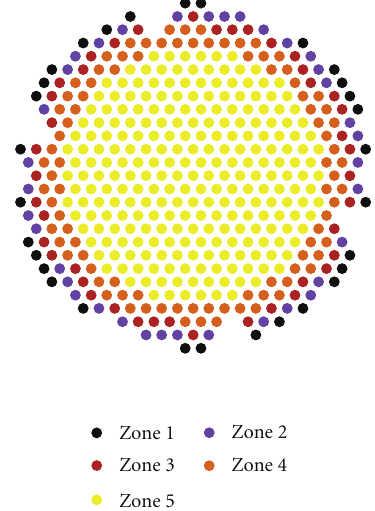
Figure 4: Configuration of the five di ff erent hydraulic